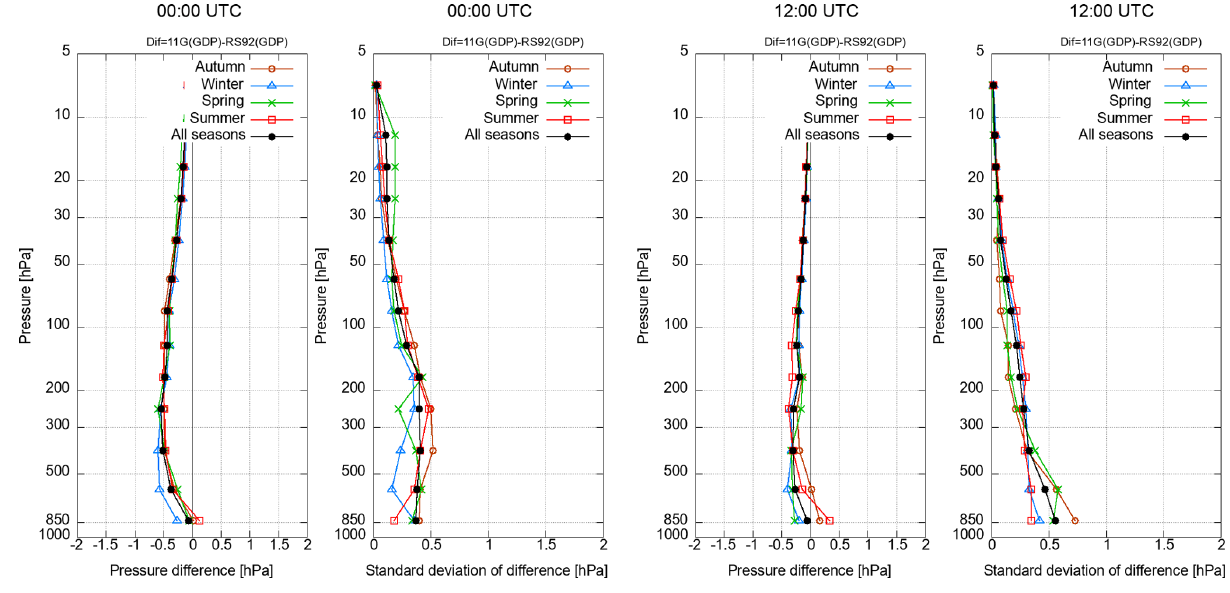
Figure 14. As per Fig. 10, but for pressure.